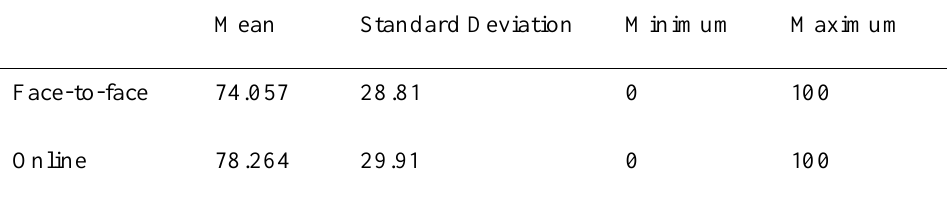
Descriptions of Academic Achievement Rates, by Study